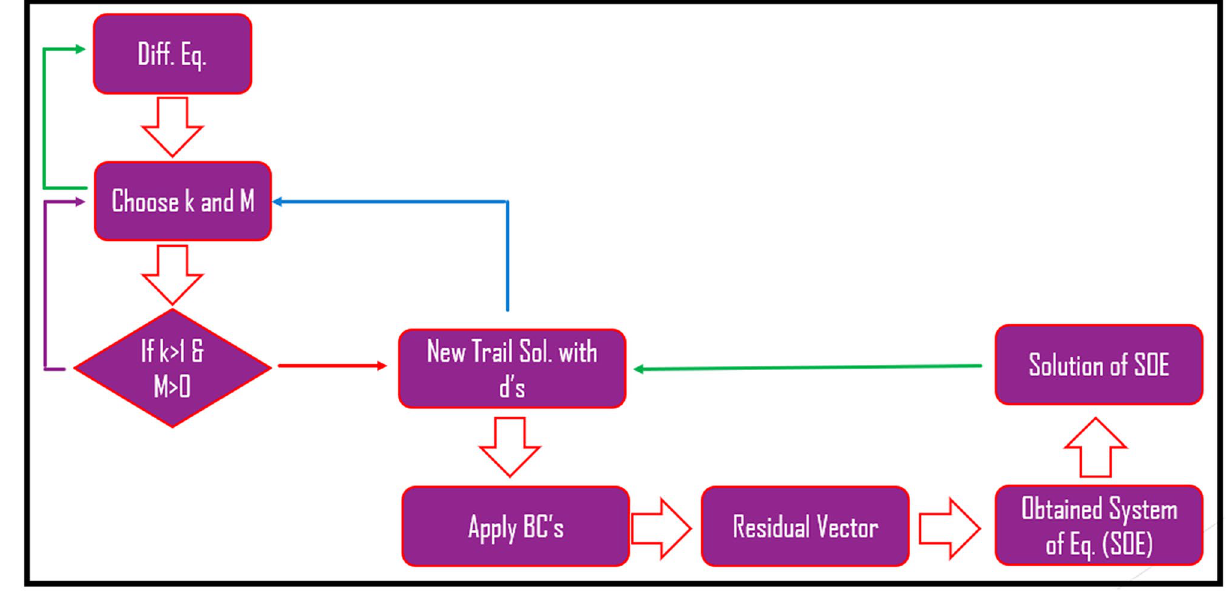
Figure 2. Flow chart of wavelets